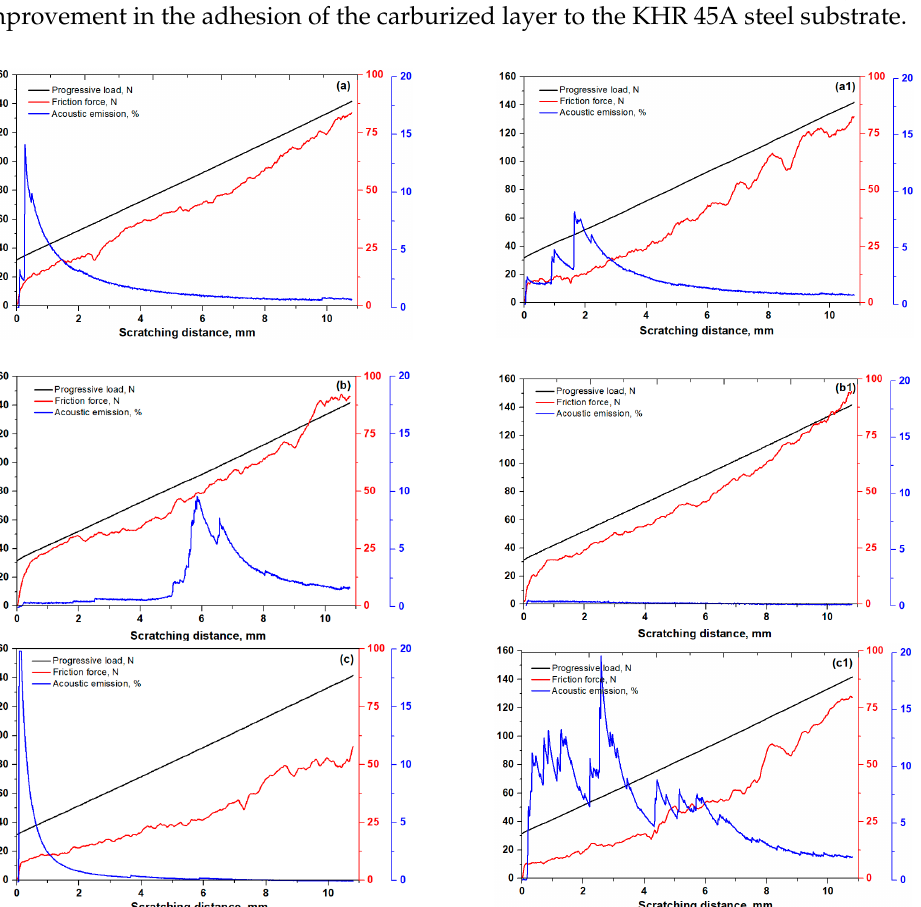
Figure 7. Comparison of scratch-induced friction force and acoustic emission of the carburized, pre-, and post-carburized UNSM-treated KHR 45A steels. ( a ) carburized KHR 45A (A), ( b ) pre-carburizing UNSM-treated KHR 45A (A), ( c ) carbu- rized KHR 45A (B), ( a1 ) carburized KHR 45A (A)+UNSM, ( b1 ) UNSM+ carburized KHR 45A (A)+UNSM and ( c1 ) carbu- rized KHR45A (B)+UNSM.